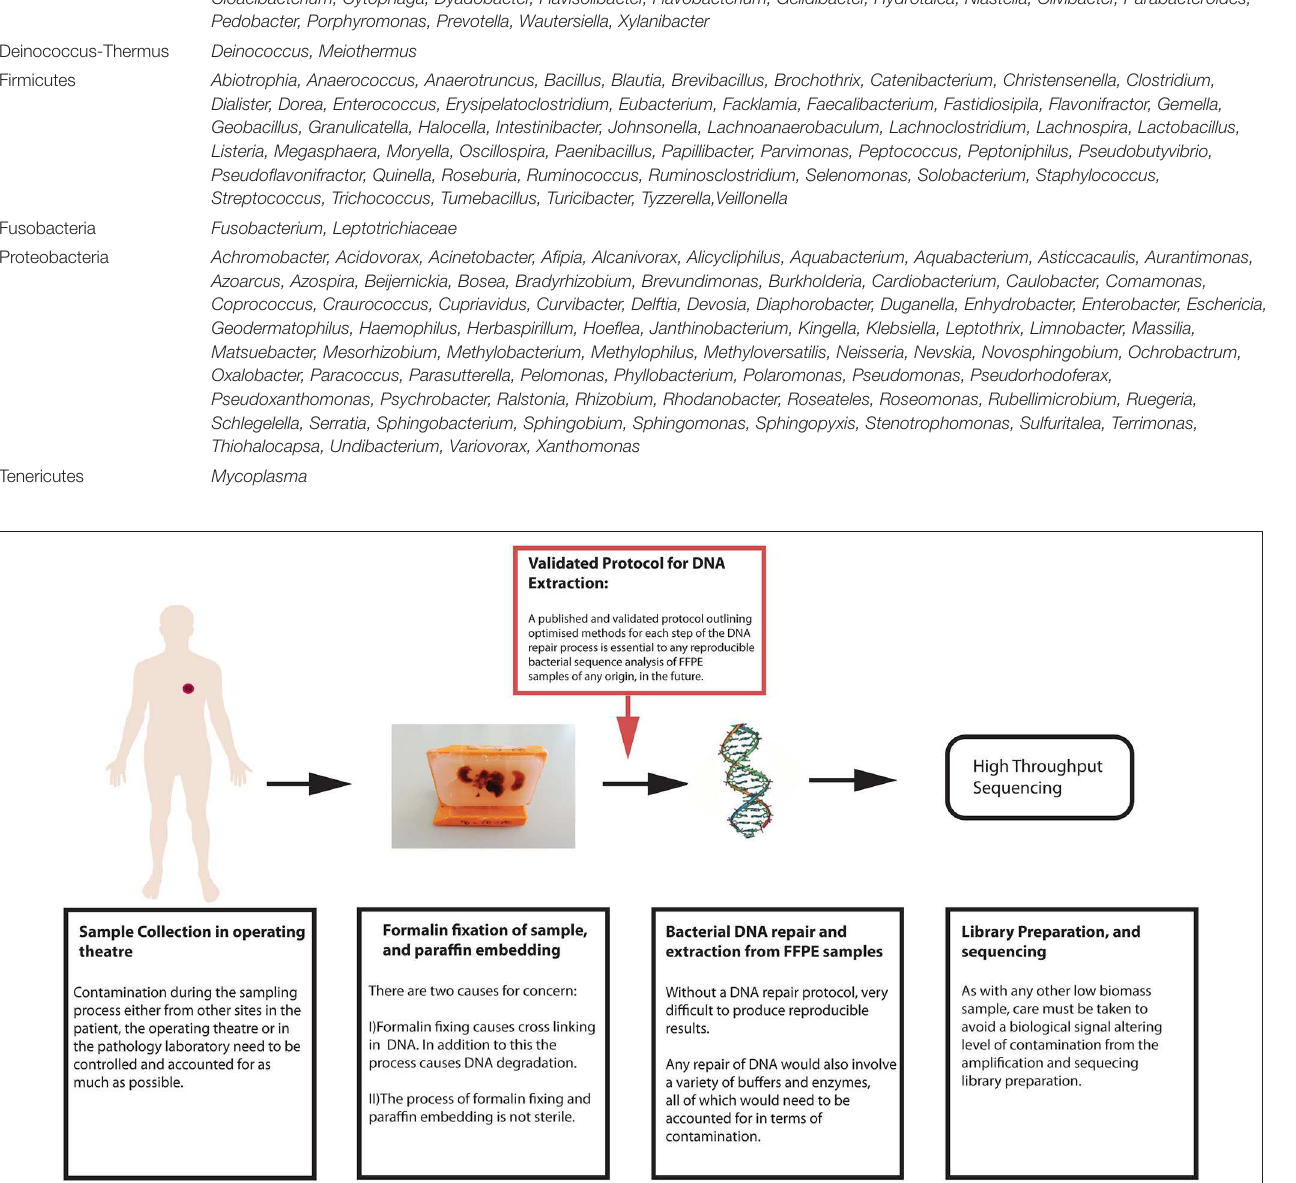
“hypervariable regions” which can be used to differentiate between bacteria with varying degrees of effectiveness